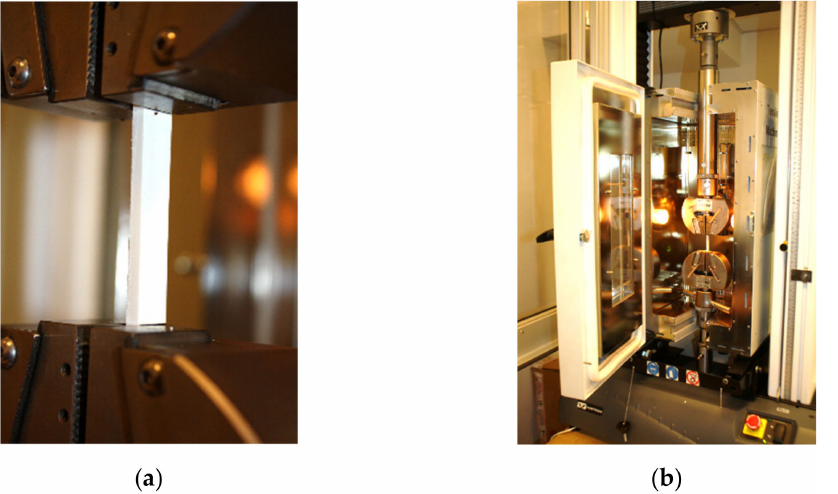
Figure 2. ( a ) Sample fixed between holders of tensile machine and ( b ) sample inserted into the oven. The length of the visible area of sample was equal to 50